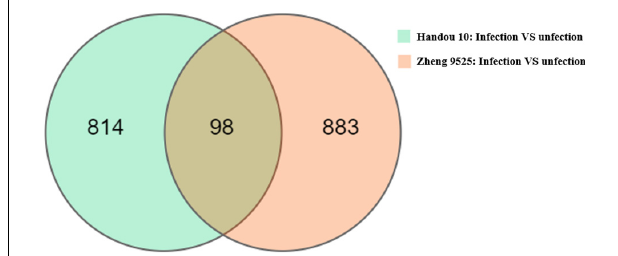
FIGURE 2 | Different expressed genes (DEGs) in Handou 10 and Zheng 9525. S: Zheng 9525 with SCN infected; R: Handou 10 with SCN infected; CK_R: mock-inoculated control from Handou 10; CK_S: mock-inoculated control from Zheng 9525.